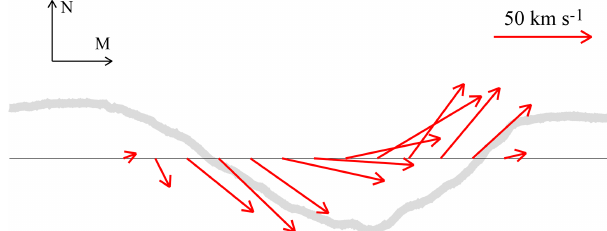
Figure 5. Ion velocities V i_md in the M – N plane during MM2. The arrows indicate the direction of the ion velocities, and their lengths indicate the amplitudes of the ion velocities. The gray line indicates the total magnetic field of